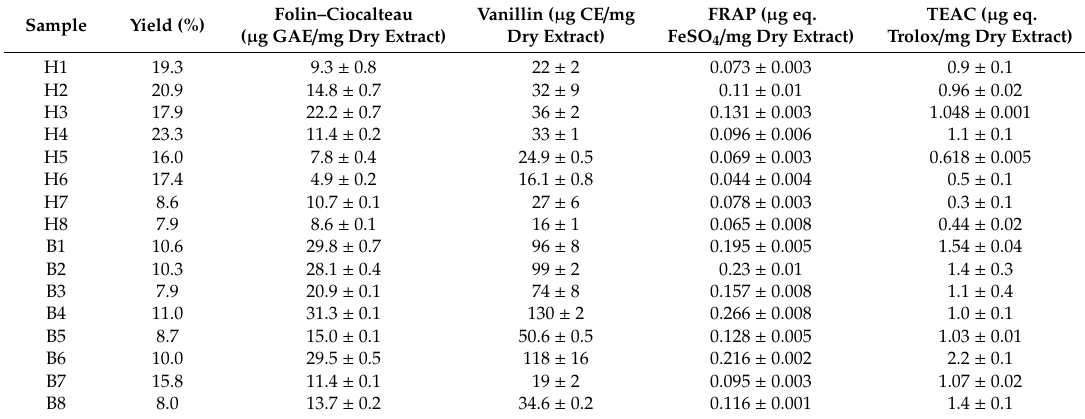
Table 2. Extraction yields and spectrophotometric results of cocoa extracts. Value = mean value ± SD.